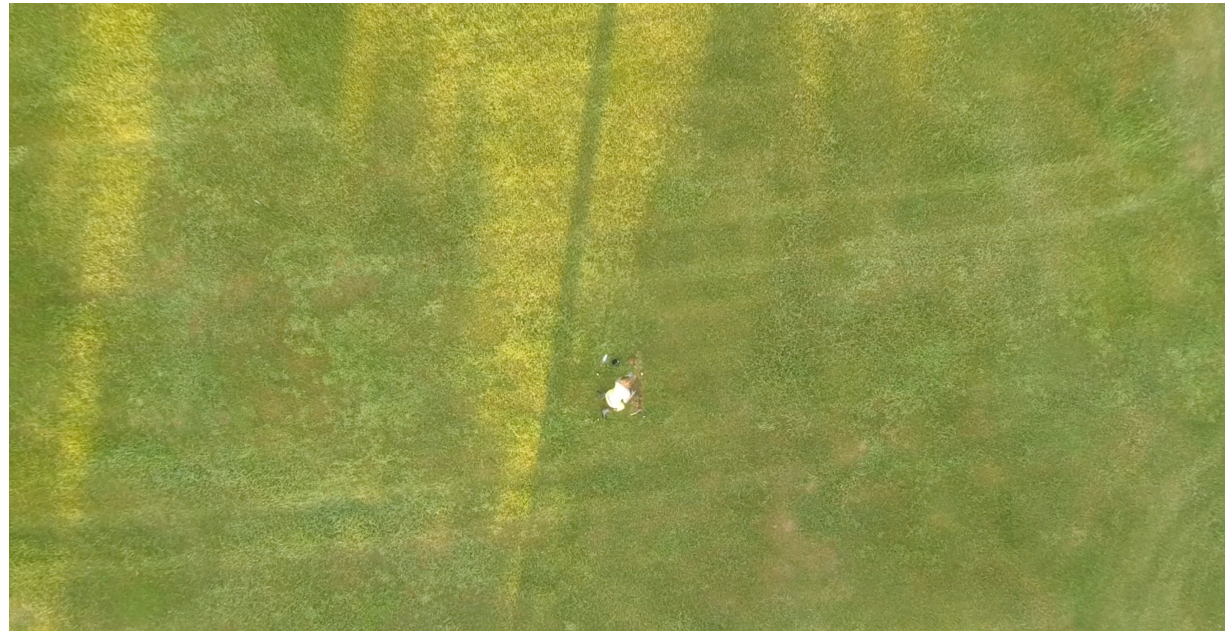
Figure 1: A brief video essay documenting the establishment of a Lawn Lab plot and its growth across a season. Video available at: